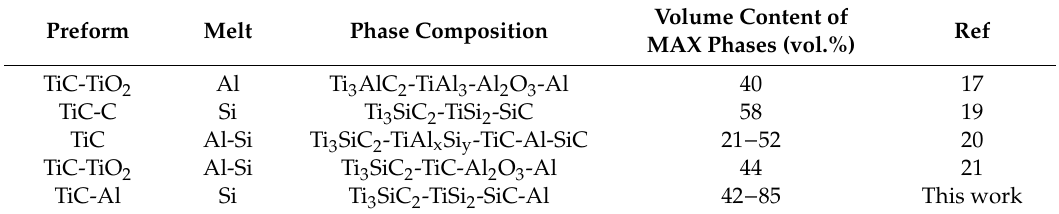
Table 2. Summary of volume content of MAX phases in the RMI-based ceramics.